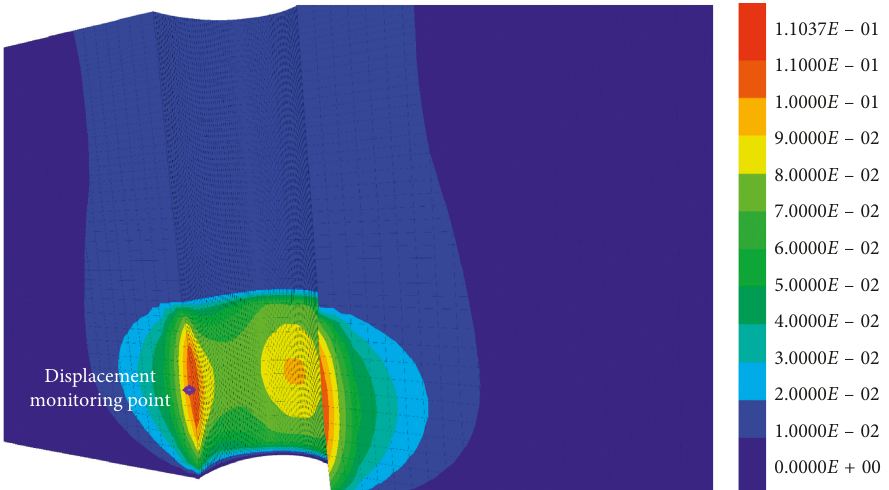
Figure 12: Deformation surrounding the body of coal bunker